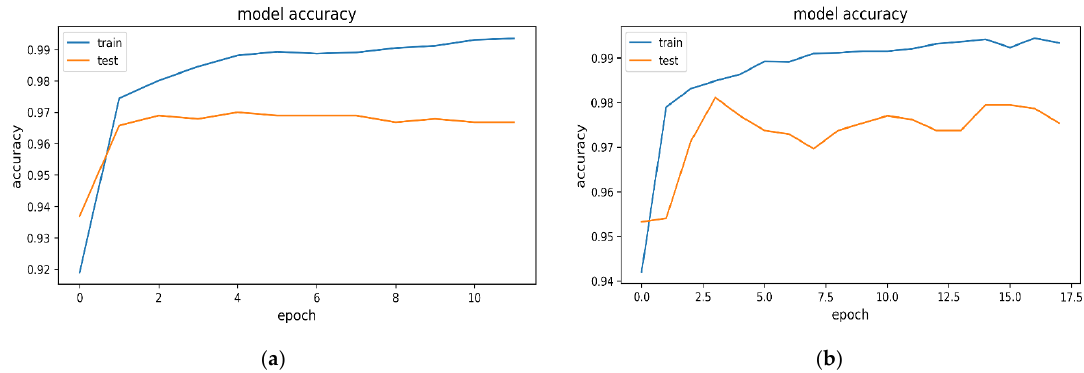
Figure 9. Training and testing accuracies for spatial attention and convolutional neural network with VGG19 model: ( a ) with class balancing on 25 Malware classes; ( b ) with class balancing on benign class.